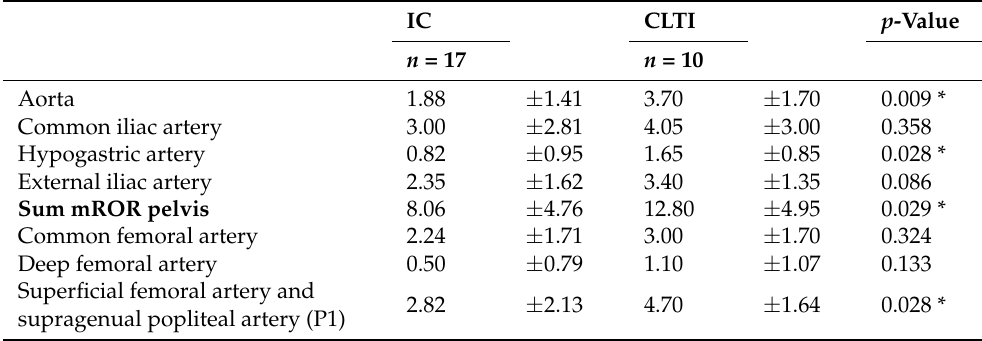
Table 3. Modified run-off resistance (mROR) scores per arterial region in three anatomical levels (pelvis, thigh, and lower leg) in non-diabetic patients with intermittent claudication (IC) or chronic limb-threatening ischemia (CLTI). The mROR values are given as the mean ± standard deviation. An asterisk * marks a p -value <